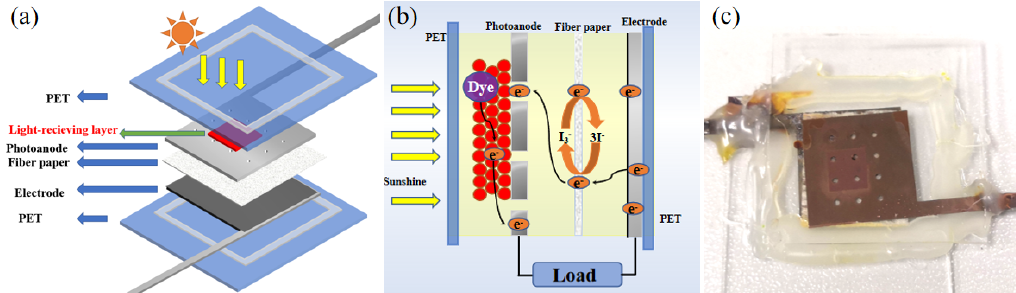
Figure 1. ( a ) Schematic diagram. A light ‐ receiving layer is prepared on the outside of a metal electrode with small holes to form a photoanode; Fiber paper serves as an insulator and an electrolyte container; a platinum black film is prepared on a metal electrode to form the counter electrode; the battery is packaged with PET and injected with electrolyte. ( b ) Photoelectric conversion diagram. ( c ) Physical drawing.